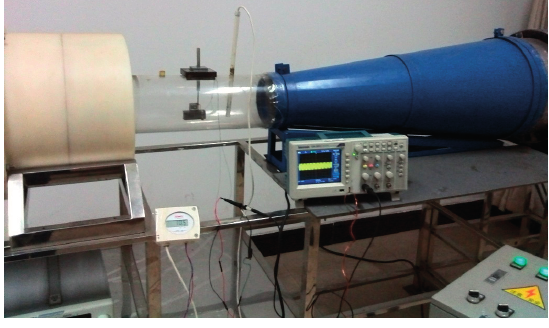
Figure 2. Experimental